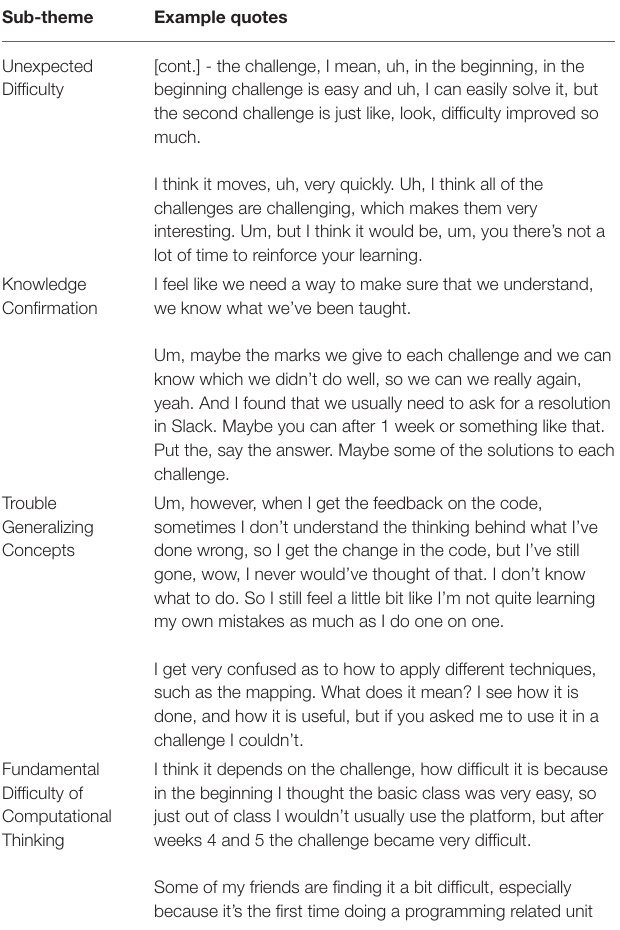
TABLE 6 | Sub-themes within the “Content Complexity”